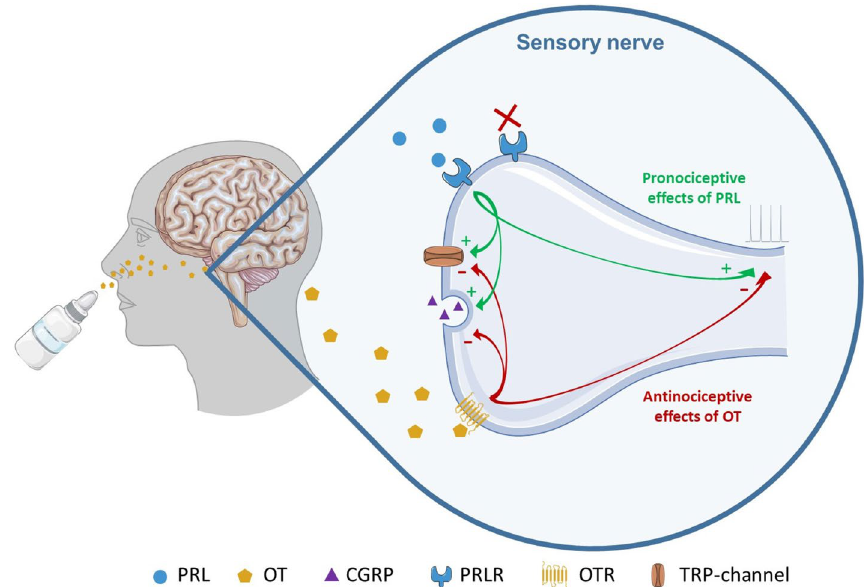
Fig. 1 Effects of OT and PRL on sensory nerves in the trigeminal system. Intranasal OT can reach the trigeminal system and activate the OTR, resulting in inhibition of CGRP release [195], desensitisation of TRPV1 channels [199] and inhibition of neuronal firing [200], leading to antinociceptive effects. PRL activates the PRLR, resulting in increased neuronal excitability [14, 99], sensitization of TRPV1, TRPM8 and TRPA1 channels [33, 79, 102, 105], and release of CGRP [15, 82], suggesting that treatment targeting PRL should aim to decrease its pronociceptive effects, e.g. using PRLR antagonists or decreasing PRL